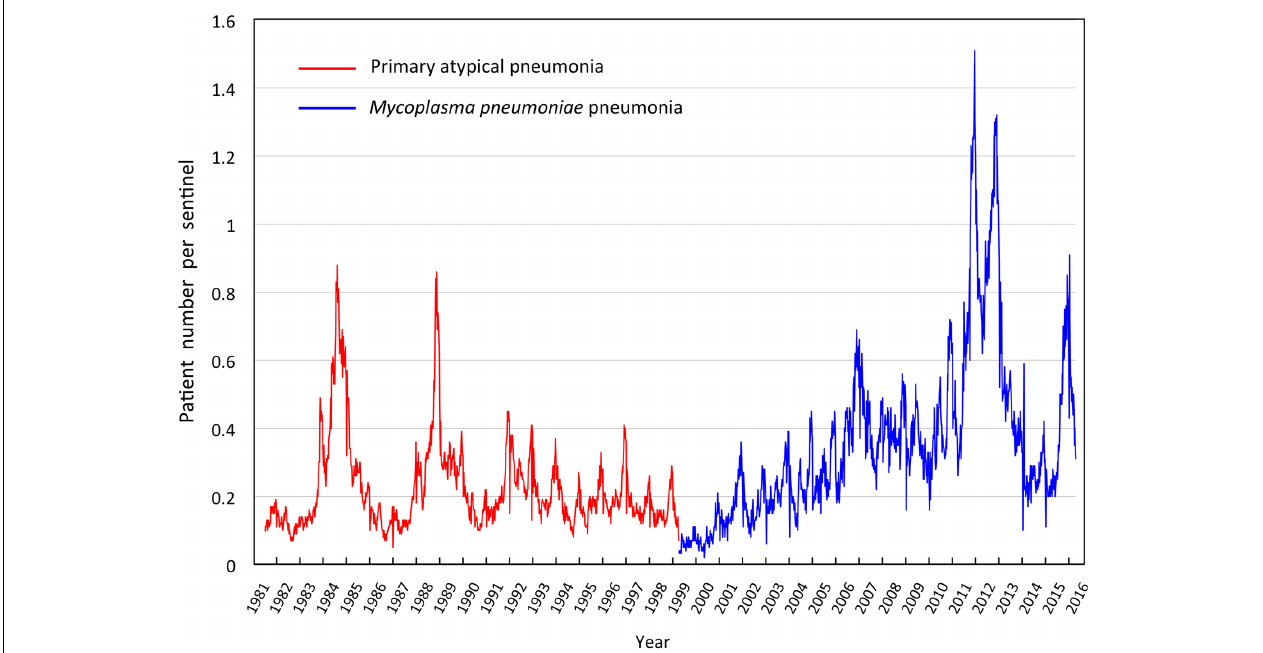
FIGURE 1 | Weekly cases of primary atypical pneumonia (from April 1981 to March 1999, red line) and Mycoplasma pneumoniae pneumonia (from April 1999 to present, blue line) in Japan reported by The National Epidemiological Surveillance of Infectious Diseases (NESID).